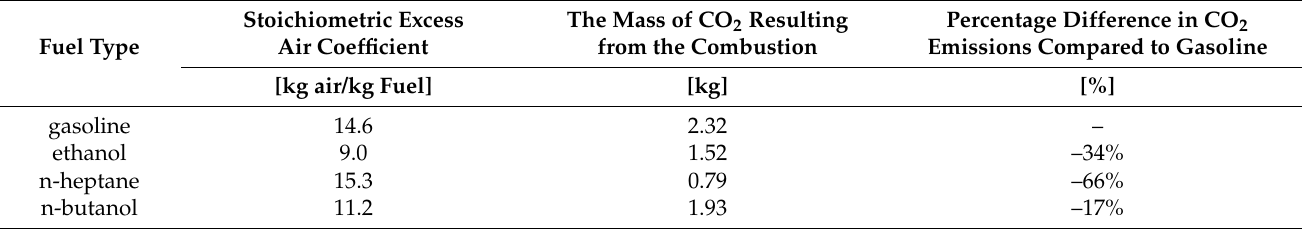
Table 2. Values of the stoichiometric excess air coefficient and CO 2 mass resulting from combustion for selected fuels [26].